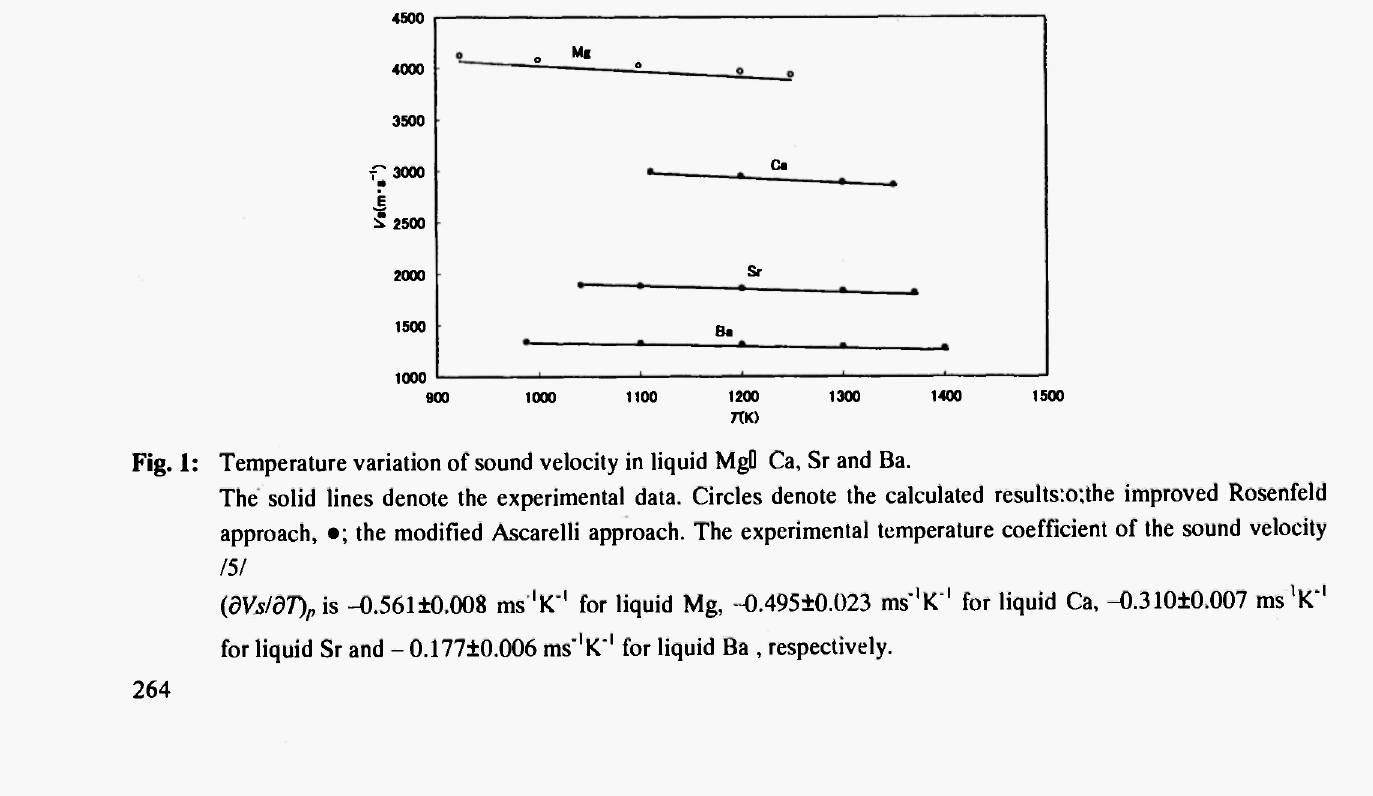
Fig. 1: Temperature variation of sound velocity in liquid MgO Ca, Sr and Ba. The solid lines denote the experimental data. Circles denote the calculated results:o;the improved Rosenfeld approach, ·; the modified Ascarelli approach. The experimental temperature coefficient of the sound velocity 151 (dVs/dT) p is -0.561 ±0.008 ms'K" 1 for liquid Mg, -0.495±0.023 ms"'K"' for liquid Ca, -0.310±0.007 ms'K"' for liquid Sr and - 0.177±0.006 ms 'K"' for liquid Ba ,